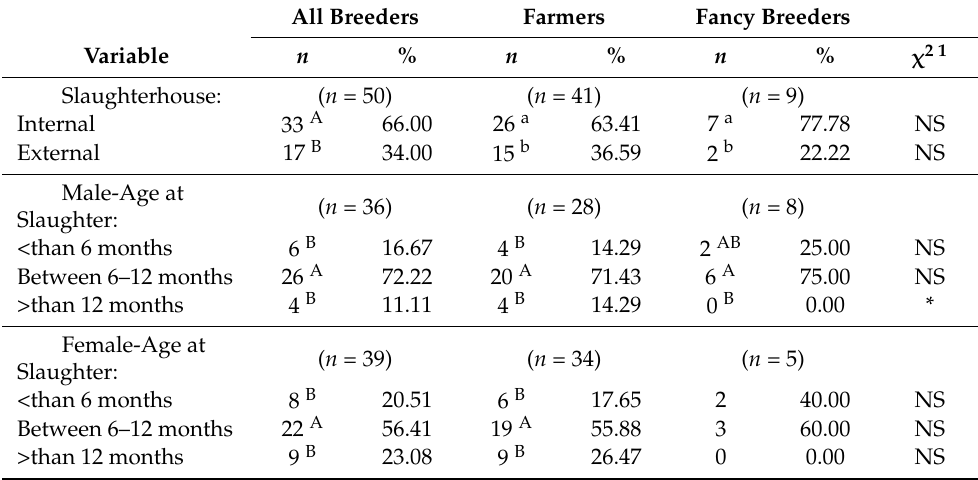
1 Chi square test for a single variable between the two breeder categories, i.e., within row comparisons; significance levels: * p < 0.05; NS, non-significant ( p > 0.05). A,B Observations with different superscripts within the column are significantly different ( χ 2 -test, p < 0.01). a,b Observations with different superscripts within the column are significantly different ( χ 2 -test, p < 0.05). The proportion of breeders rearing birds for meat production with the sole aim of satisfying self-consumption or local markets was similar (45% and 32%,